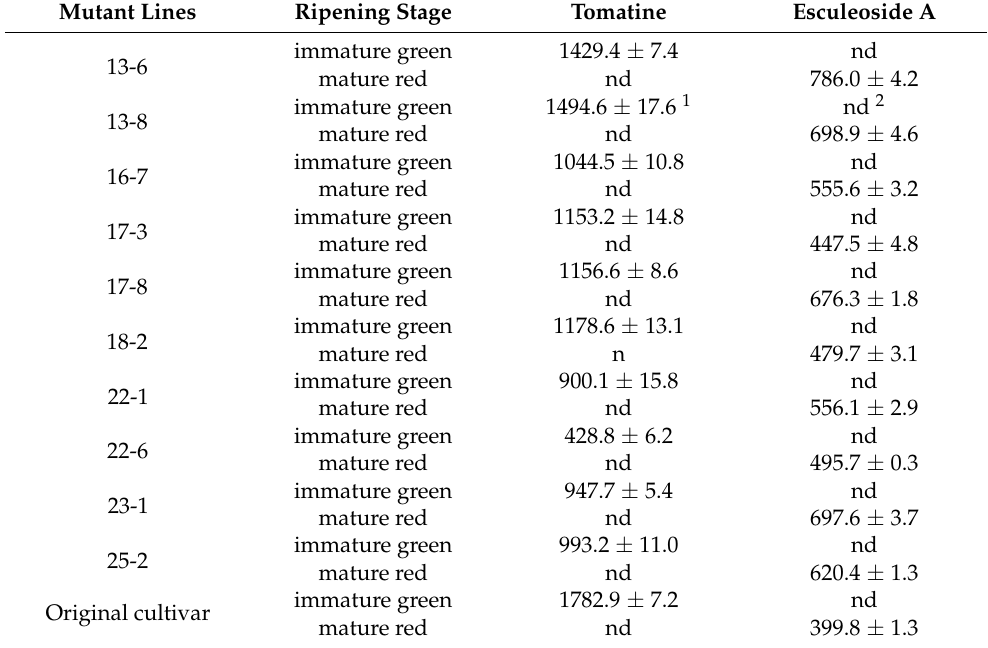
Table 3. Content of two triterpenoid glycosides ( µ g/g of fresh weight) in the top 10 mutant lines with high esculeoside A content among the ripe red fruits of mutant tomato lines.